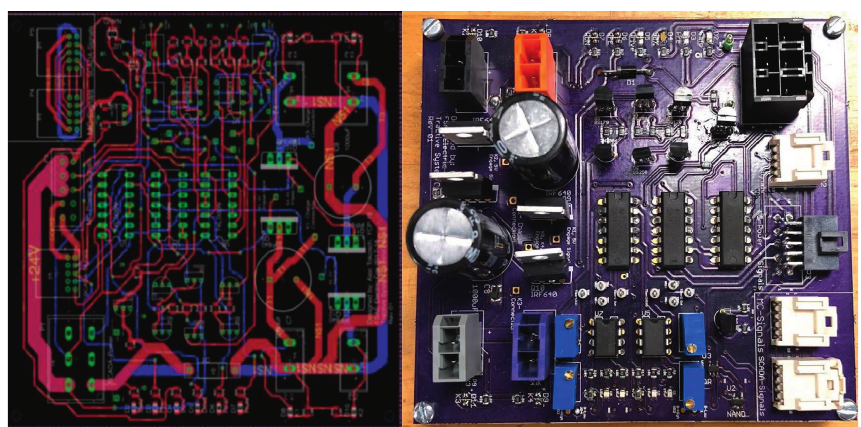
Figure 7: The final PCB design and actual hardware of the